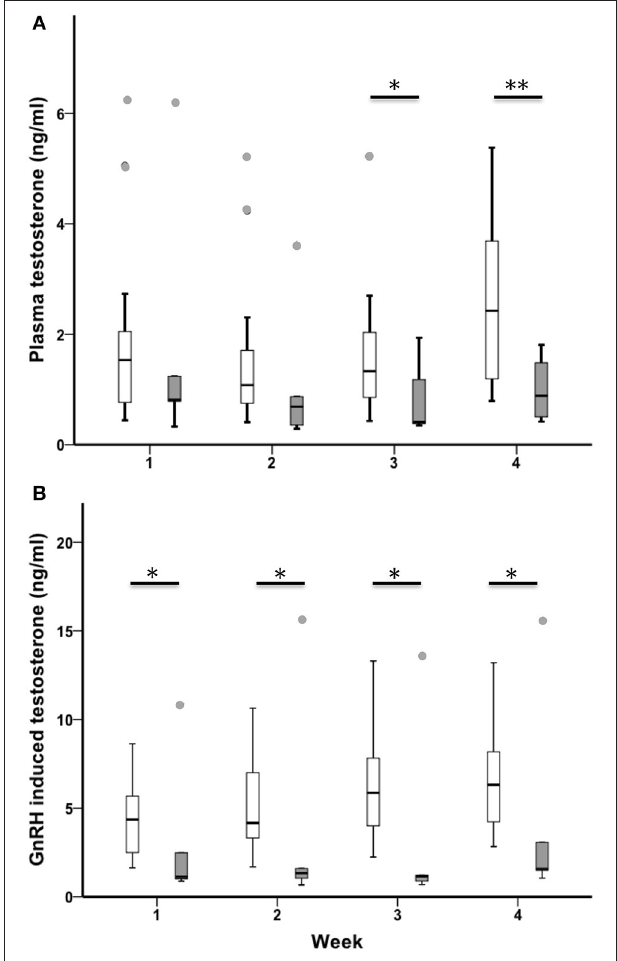
FIGURE 4 | Male sedentary urban juncos (white boxes) and migrant juncos (gray boxes) did not differ in plasma testosterone until the third week of sampling (12 & 13 March) (A) . Sedentary urban juncos had higher levels of testosterone in response to GnRH-challenge (B) than migrant male juncos throughout the study (* p ≤ 0.05; ** p ≤ 0.01). The samples were collected on the following dates: 1 = 26 & 27 February, 2 = 5 & 6 March, 3 = 12 & 13 March, 4 = 19 & 20 March. Boxes represent upper quartile, median, and lower quartile. Whiskers include the range of values except for outliers. Outliers include values > 1.5 box lengths